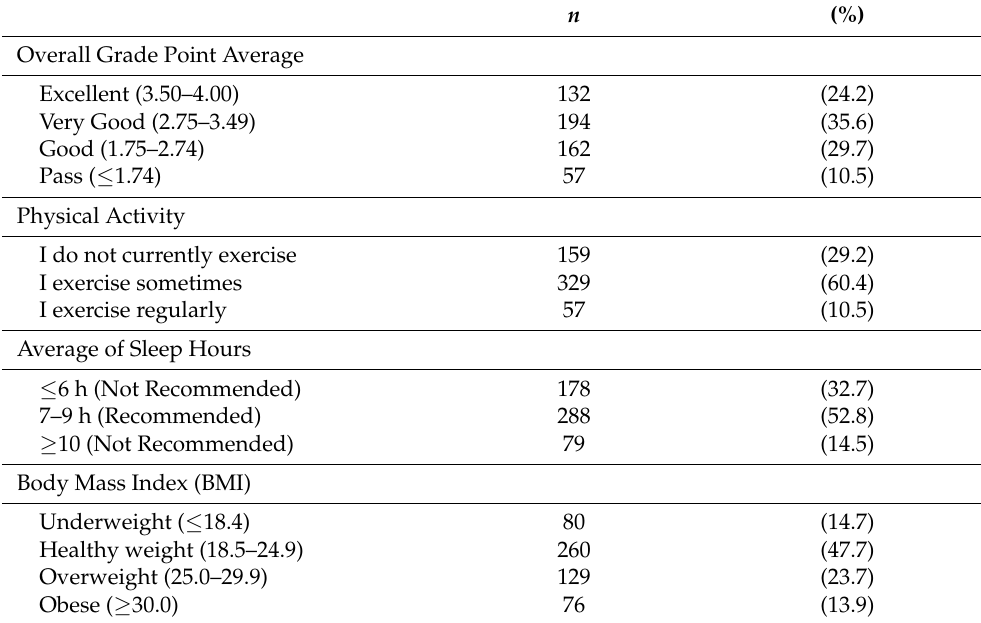
Table 4. Distribution of academic, physical health and mental well-being, N =